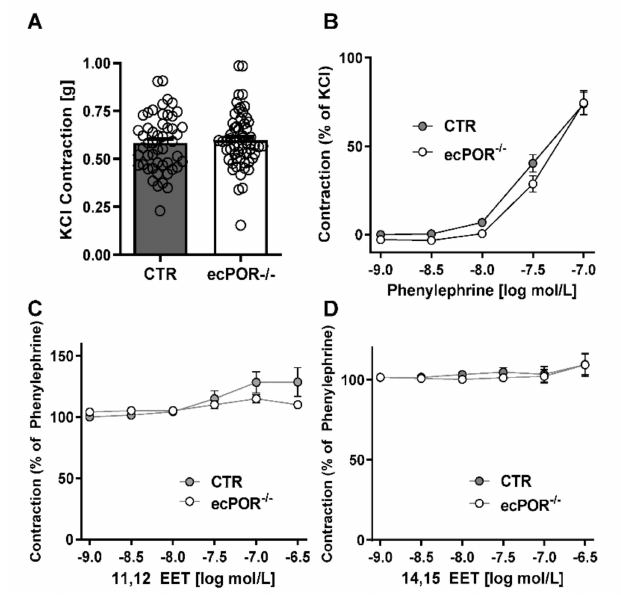
Figure 2. Epoxyeicosatrienoic acids do not modulate phenylephrine − induced vasoconstriction. ( A ) Constrictor response to KCl (80 mM) in aortic rings from mice of the genotype indicated. ( B ) Con- centration curve for contraction to phenylephrine. ( C ) Concentration–relaxation curves to 11, 12-EET and ( D ) 14, 15-EET using aortic rings of CTR and ecPOR − / − mice. n ≥ 12 aortic rings per condition. Two-way ANOVA with Bonferroni post-test.